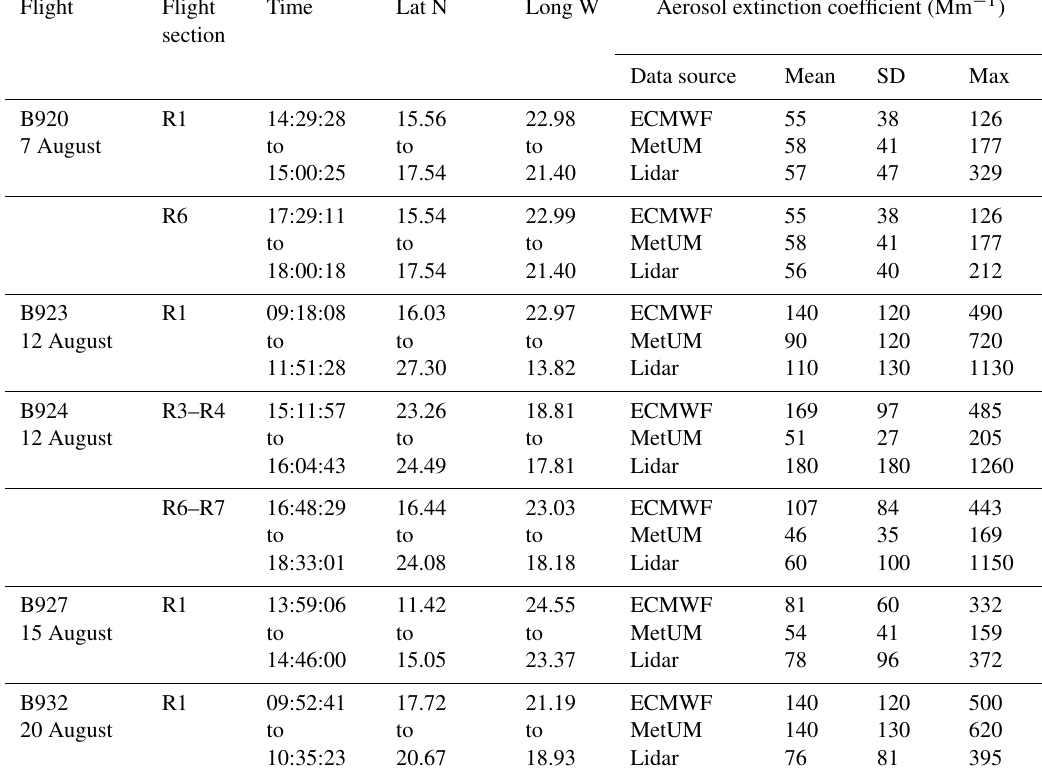
Table 1. Summary of the high-level sections from each of the flights used here. Flight sections are labelled with the letter R (runs); see the text. All times are in UTC.